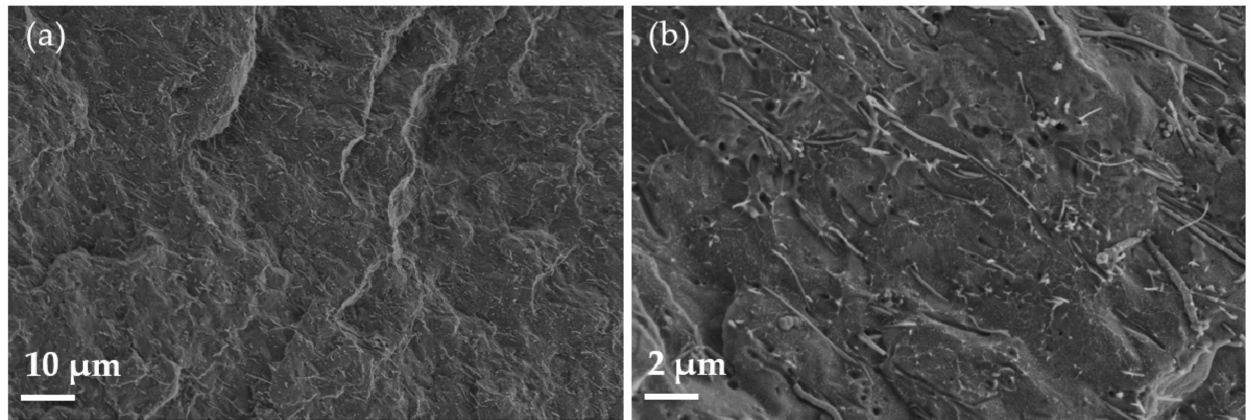
Figure 2. SEM micrographs of the PP/5wt.% CNF composite at lower ( a ) and higher ( b )